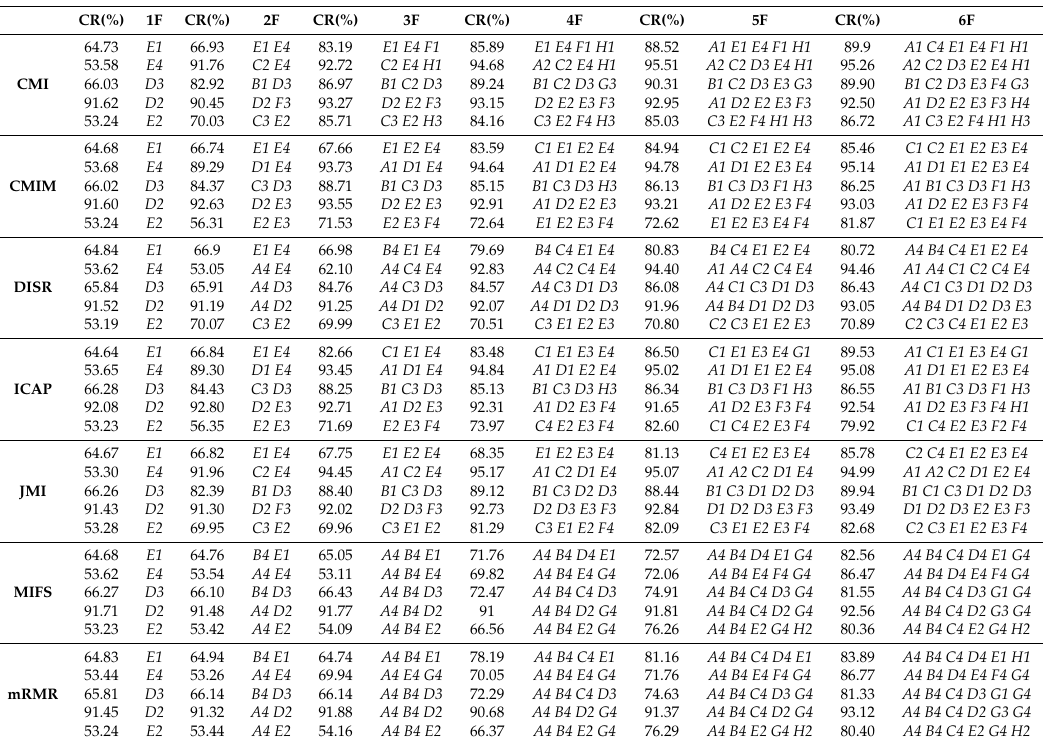
Table 4. CR (a) and F1-score (b) numerical results for best features for the automatic feature selection algorithms analyzed and each WT. Results are grouped in sub-tables for each algorithm, and each row of each sub-table corresponds to wind turbines (WT1 to WT5). The selected features are coded with the variable codes detailed in Table